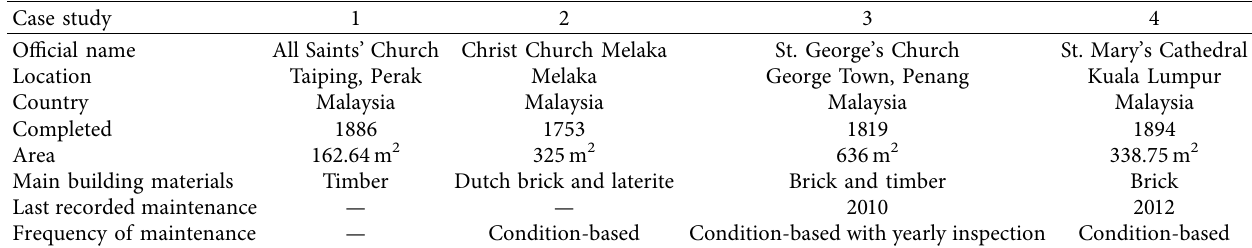
Table 3: Building profles of National Heritage Anglican churches in Malaysia.